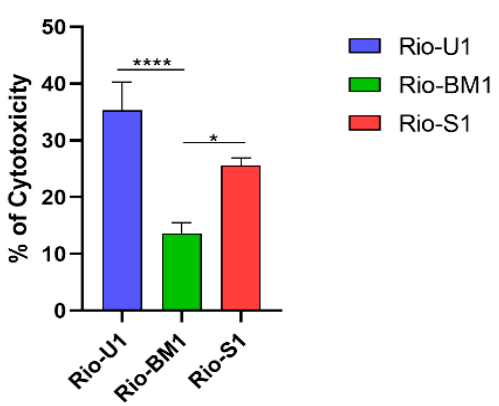
Figure 5. ZIKV-induced cytotoxicity in Vero cells at 24 h post-infection at MOI 0.02. Statistical analyses were performed in GraphPad Prism 8, by Ordinary One-Way ANOVA with Tukey’s multiple comparisons tests: * represents p ≤ 0.05, and **** represents p ≤ 0.0001.